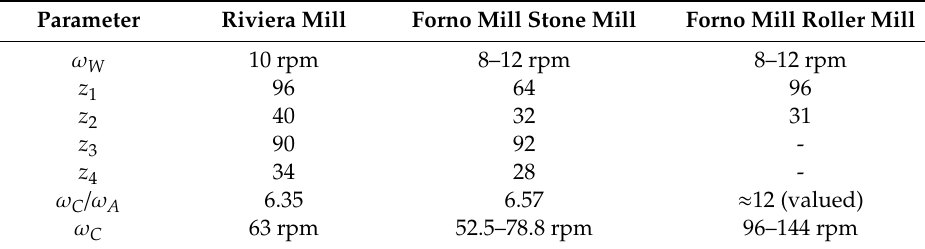
Table 3. Functional parameters of the power transmissions.